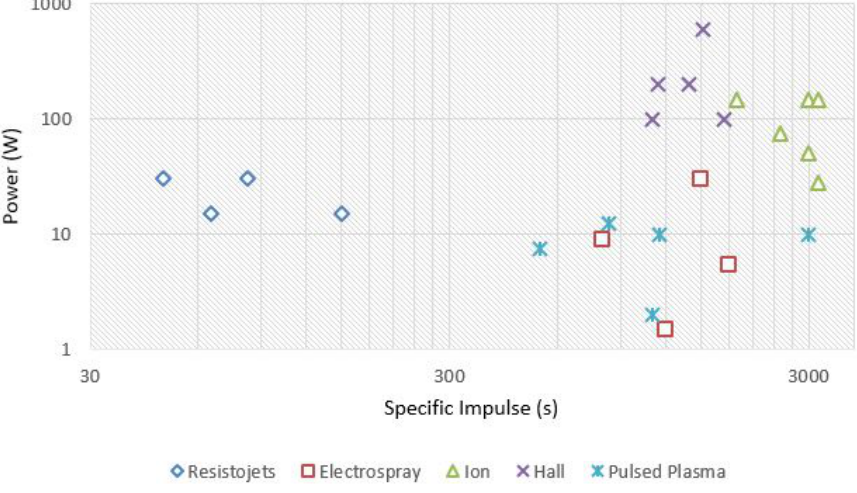
Figure 10. Power vs. Specific Impulse for Electric Propulsion Systems from Survey.